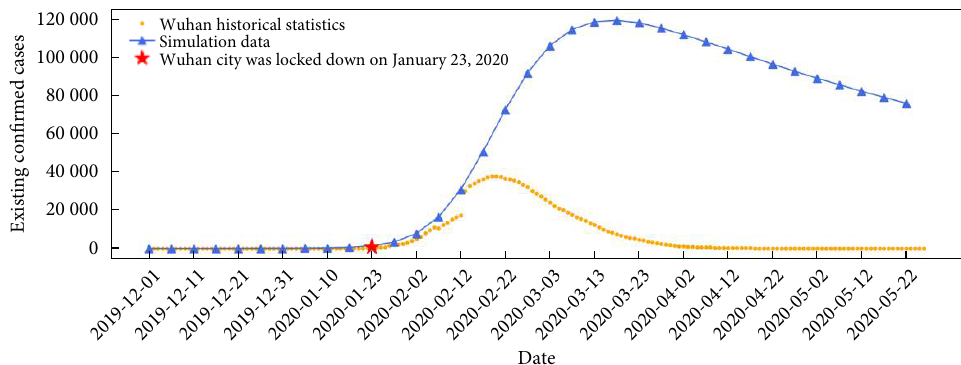
Fig. 7 Comparison between free simulation and historical statistics of Wuhan.